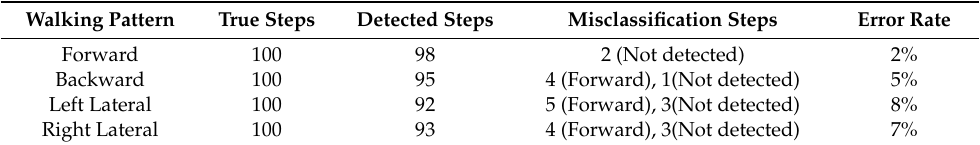
Table 1. Error of multi-pattern-based step detection.